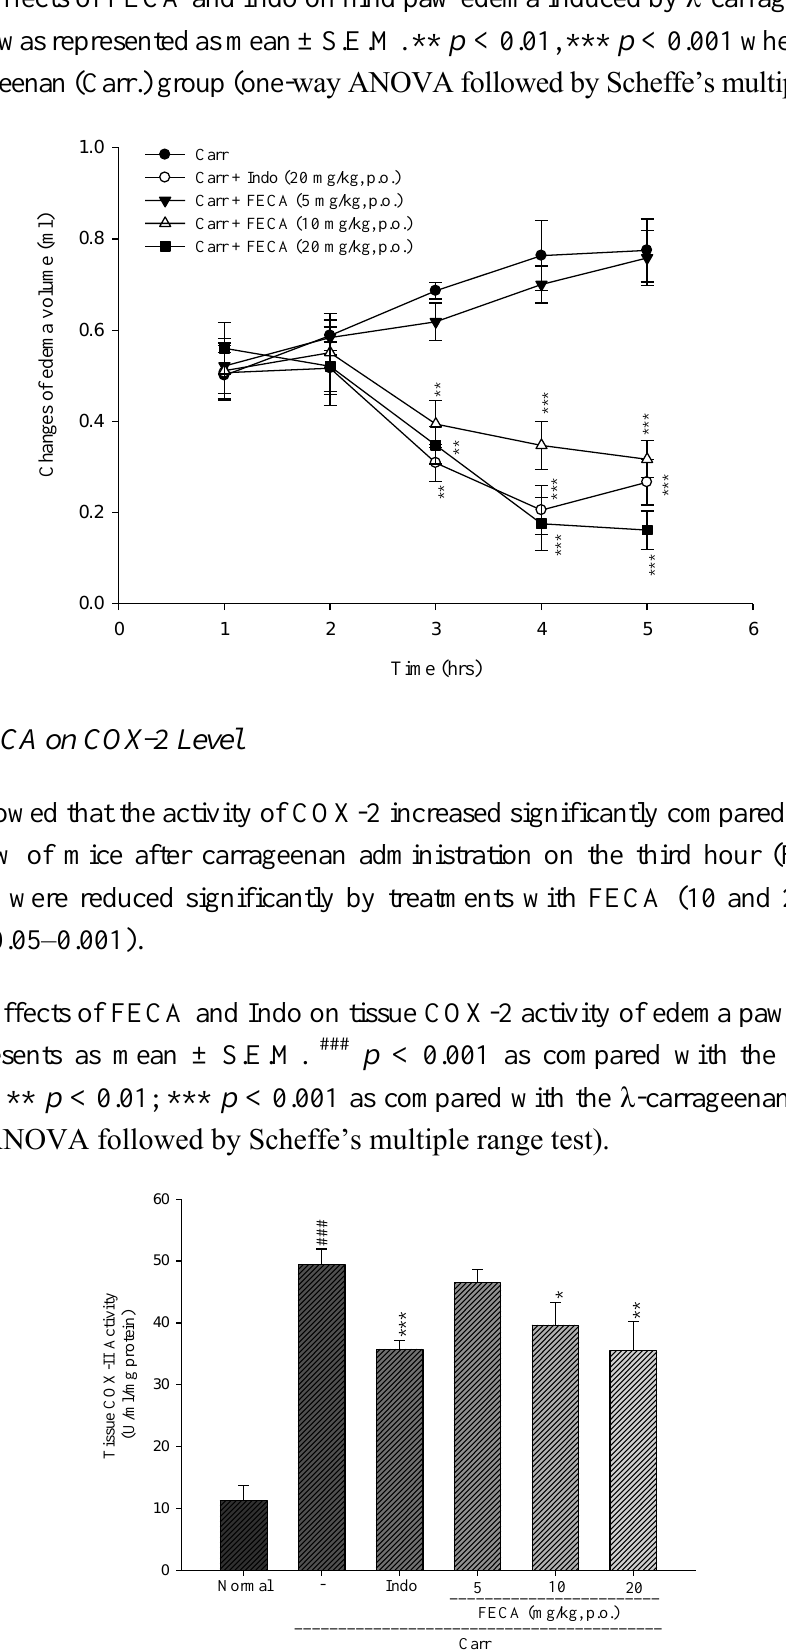
Figure 1. Effects of FECA and Indo on hind paw edema induced by λ-carrageenan in mice. Each value was represented as mean ± S.E.M. ** p < 0.01, *** p < 0.001 when compared to